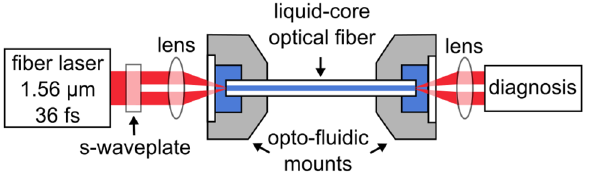
Figure 2. Experimental setup for soliton-driven HOM-SCG in LCFs. The ultrashort pulses are spatially modified by a commercial s-waveplate and coupled into the fiber by an aspheric lens ( NA = 0.55, f = 4.51 mm). For the outcoupling another aspheric lens ( NA = 0.56, f = 6.00 mm) is used to feed the light into a large core fluoride fiber connected to a spectrometer or to image the beam with an infrared